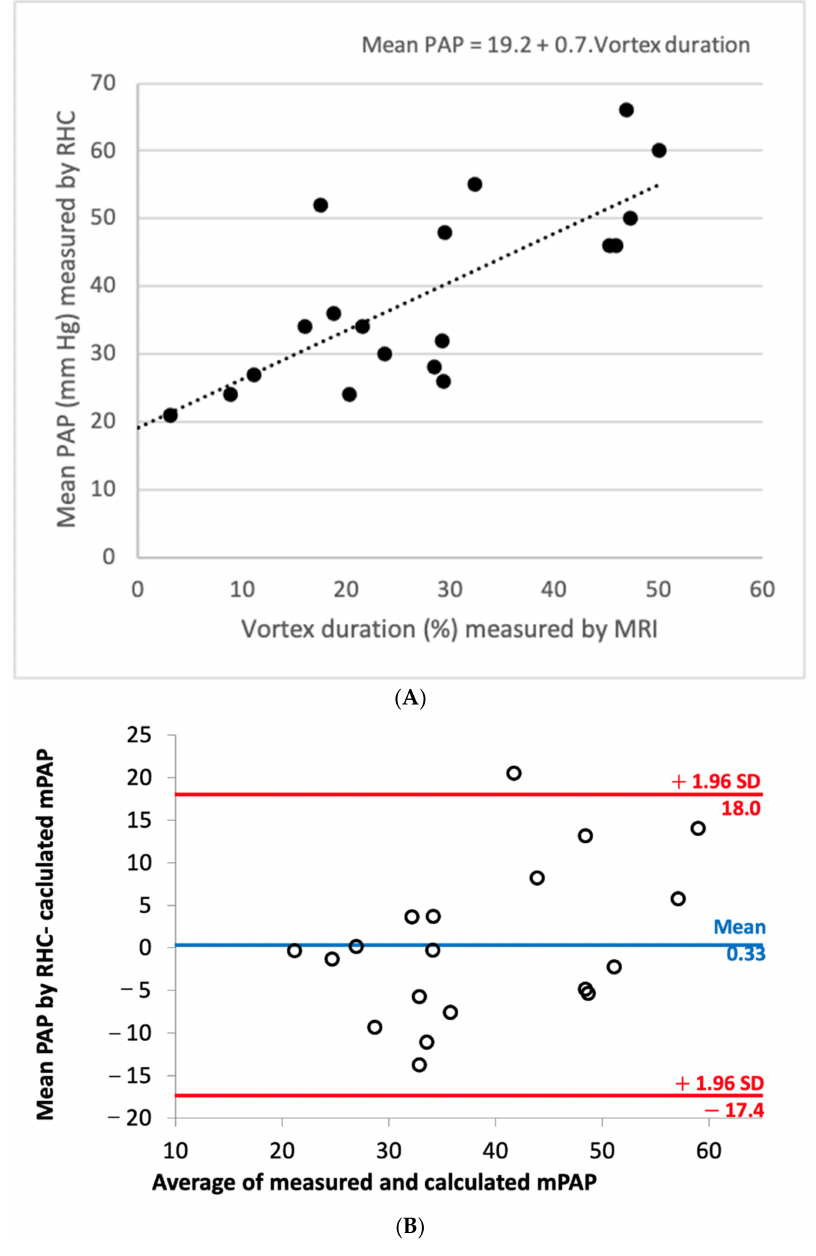
Figure 4. ( A ) Correlation and linear regression line between vortex duration (%) measured by MRI and mPAP (mmHg) measured by RHC. ( B ) Bland–Altman plot of mPAP measured by RHC and calculated by the regression equation mPAP (mmHg) =19.2 + 0.7 × vortex duration (%), with 95% limits of